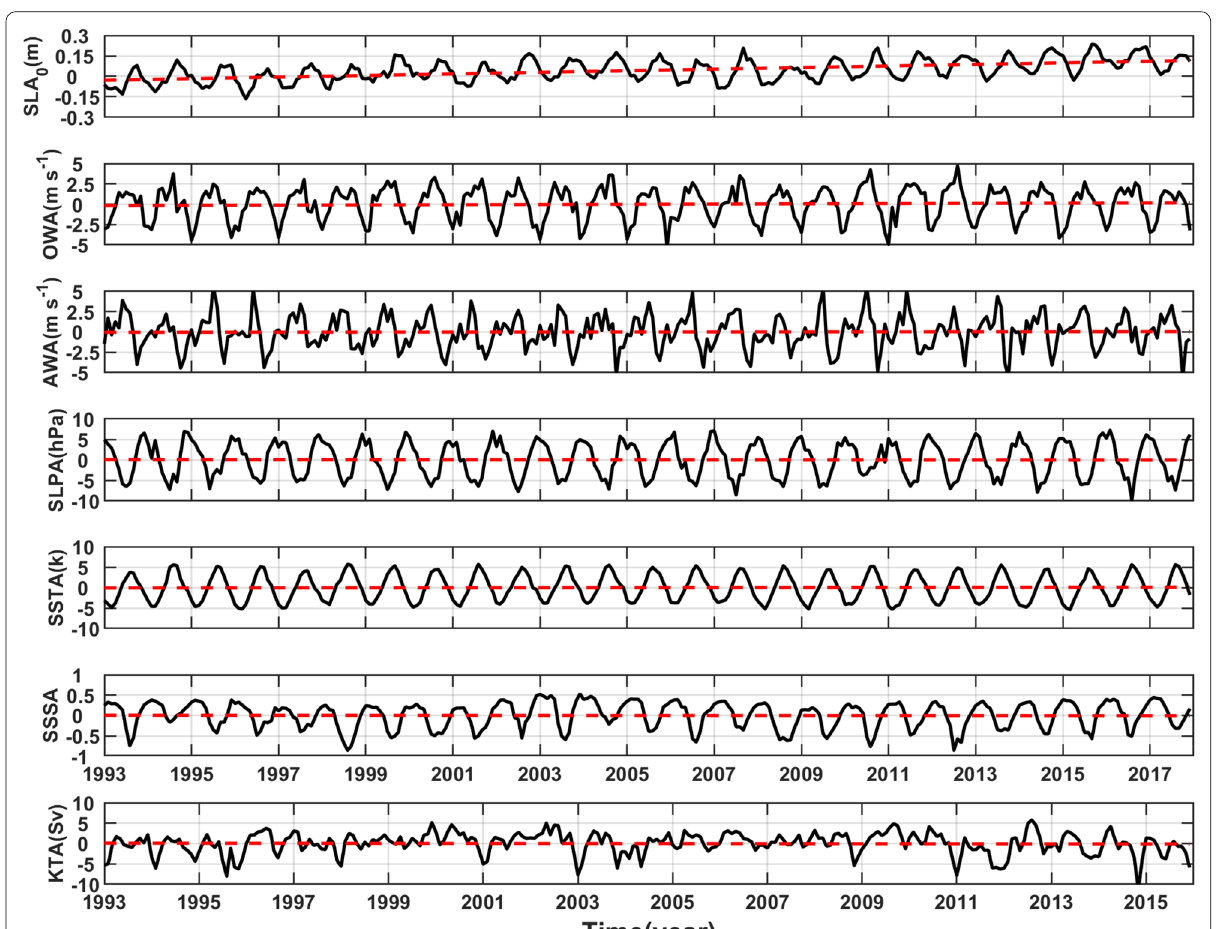
Fig. 4 The time series of averaged SLA 0 , OWA, AWA, SLPA, SSTA, SSSA and KTA south of the Kuroshio extension. The red dash lines denote the linear trend over the